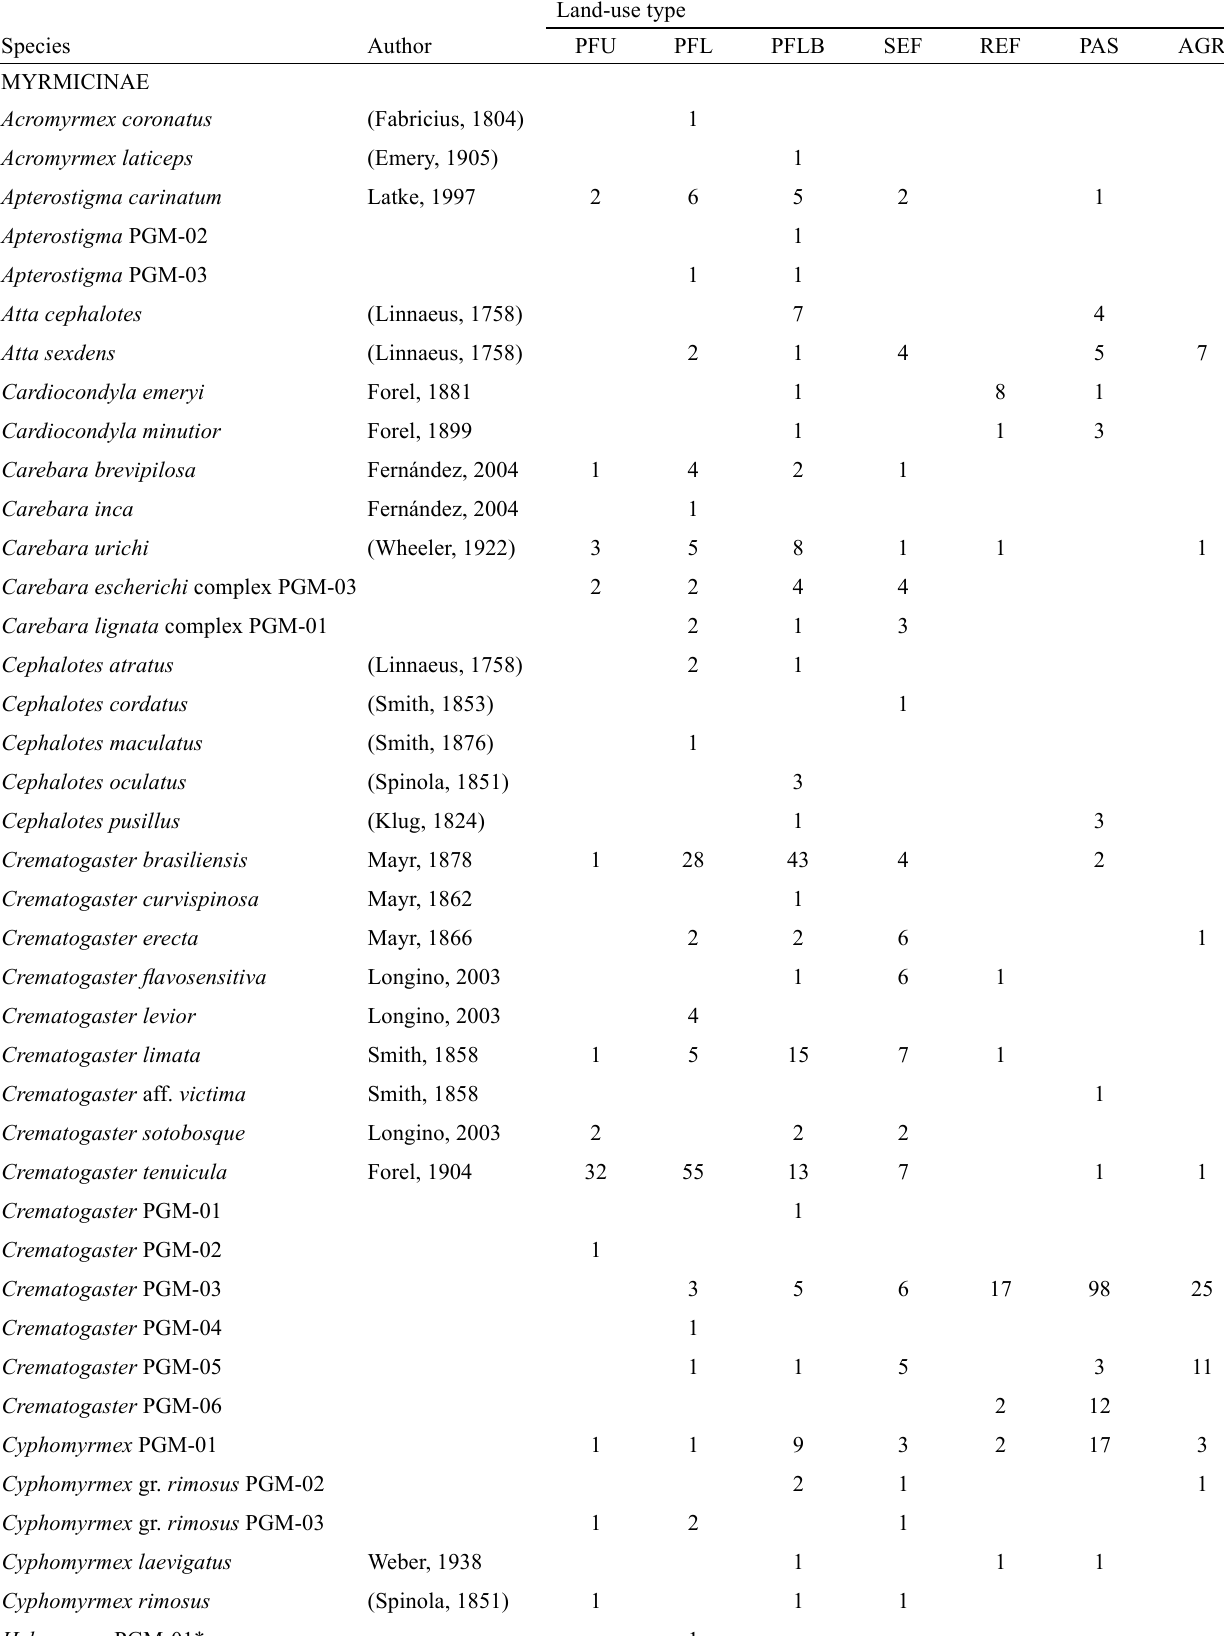
Table 2 . List of ant species collected in this study. Values represent number of records per pitfall traps of each species in each land-use type: PFU – primary forest undisturbed, PFL – primary forest logged, PFLB – primary forest logged and burnt, SEF – secondary forest, REF – reforestation with commercial species, PAS – pasture, AGR – agricultural areas.